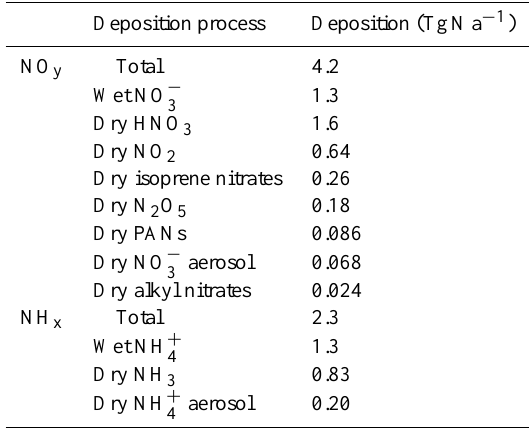
Table 3. Nitrogen deposition over the contiguous US a .